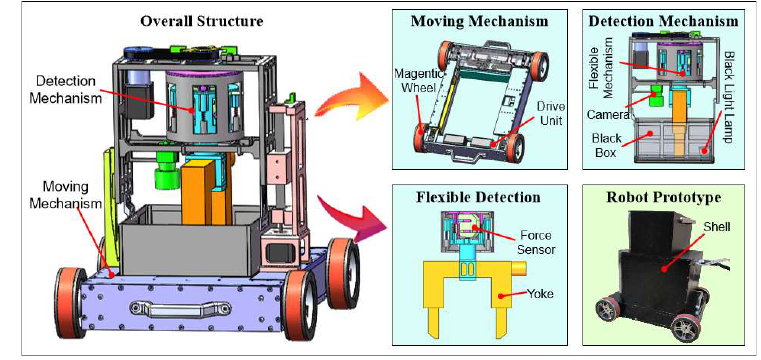
Figure 1. Overall architecture of the detection robot.